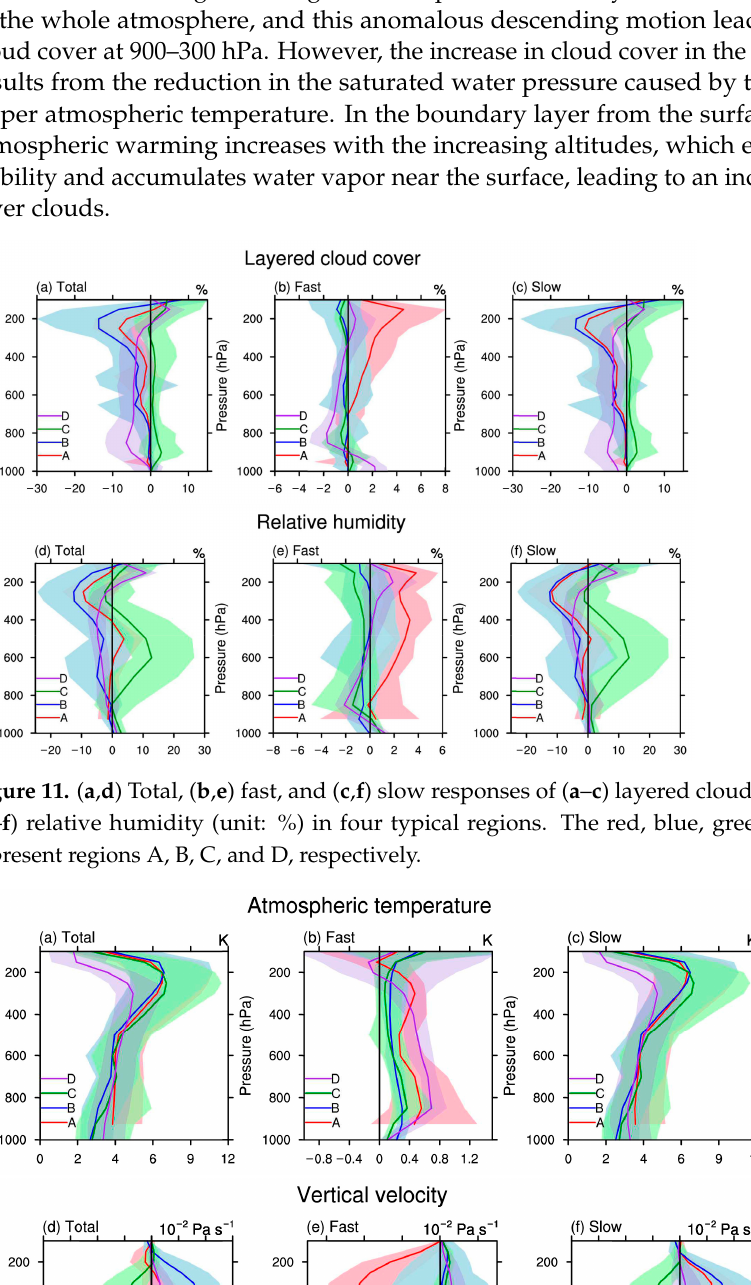
Figure 11. ( a , d ) Total, ( b , e ) fast, and ( c , f ) slow responses of ( a–c ) layered cloud cover (unit: %) and ( d–f ) relative humidity (unit: %) in four typical regions. The red, blue, green, and purple lines represent regions A, B, C, and D, respectively.